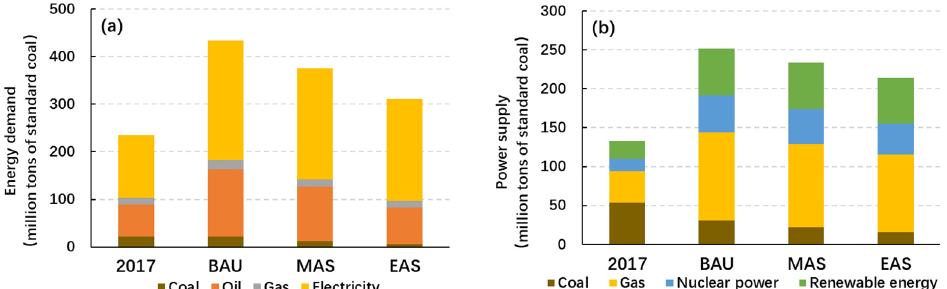
Figure 4. Demand of energy development and electric supply of base year and three scenarios in 2035 of PRD: ( a ) energy consumption structure, ( b ) power structure. 2035 of PRD: ( a ) energy consumption structure, ( b ) power